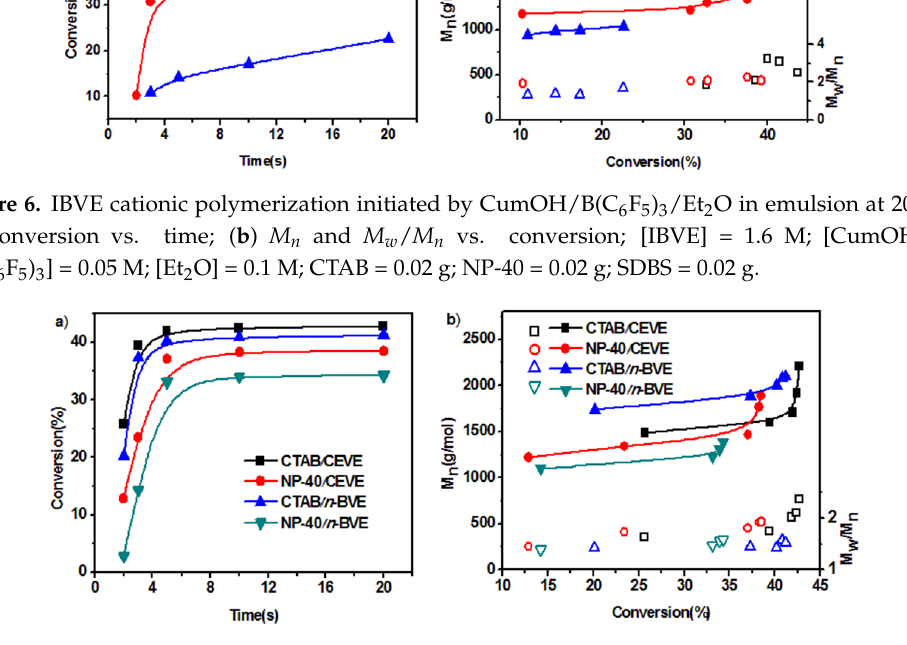
Figure 7. CEVE and n -BVE cationic polymerization initiated by CumOH/B(C 6 F 5 ) 3 /Et 2 O in an emulsion at 20 ◦ C: ( a ) conversion vs. time; (b) M n and M w / M n vs. conversion; [CEVE] = 2.0 M; [ n -BVE] = 1.6 M; [CumOH] = [B(C 6 F 5 ) 3 ] = 0.05 M; [Et 2 O] = 0.1 M; CTAB = 0.02 g; NP-40 = 0.02